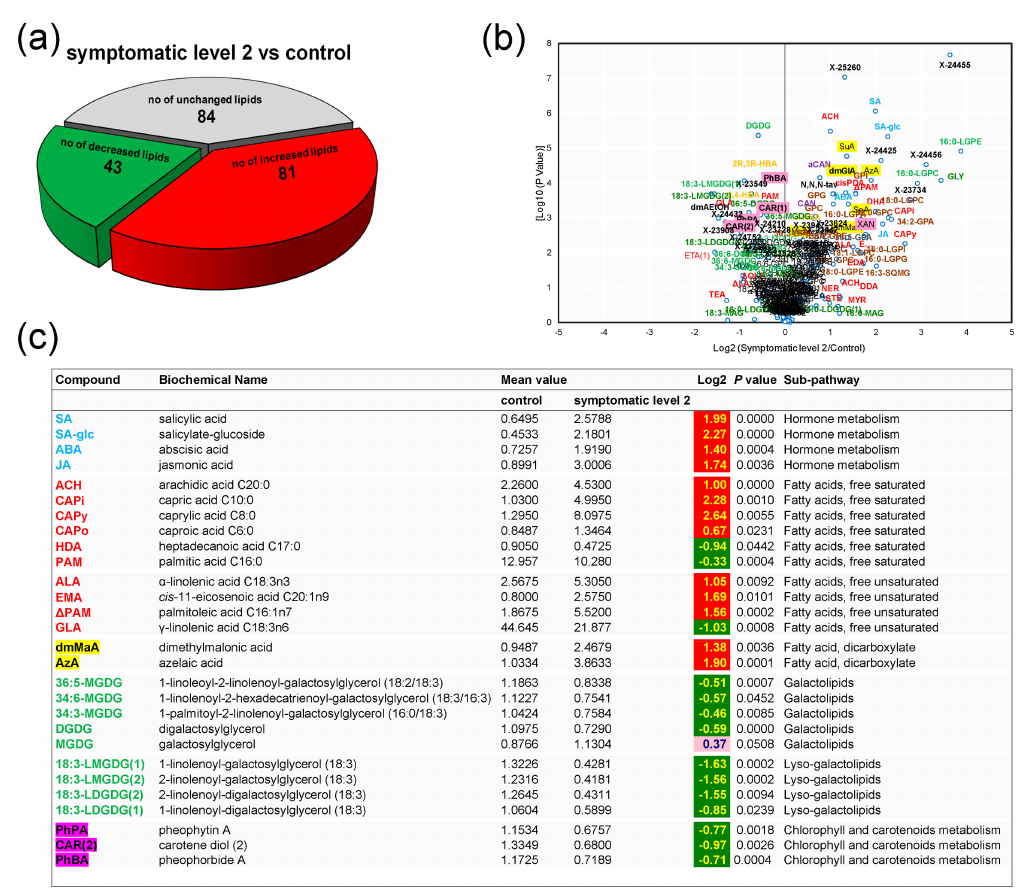
Figure 4. Variations in levels of hormones, lipid species, and other compounds of the metabolism of lipids in Vitis vinifera L. ‘Malvasia fina’ a ff ected by Esca complex disease (ESCA): ( a ) Pie plot representing the numbers of altered species is spotted / scorched leaves from foliar-symptomatic and wood-symptomatic vines (SY2) relative to healthy leaves from healthy una ff ected control vines (CTL). Levels were considered altered when they underwent a p -value ≤ 0.10 (Welch’s two-sample t -test, n = 6). ( b ) Volcano plot (log2 (SY2 / CTL) vs. [log10 ( p -value)]) illustration of species di ff erently accumulated in CTL and SY2. Abbreviations are as listed in Figure 4c and Table S1. ( c ) Representative compounds listed along a color gradient according to sub-pathways. Additional altered compounds can be found in Table S1. For log2 values, di ff erent colors represent di ff erent directions of change at p ≤ 0.05 (dark green = negative change; red = positive change) and at p ≤ 0.10 (light green = negative change; rose = positive